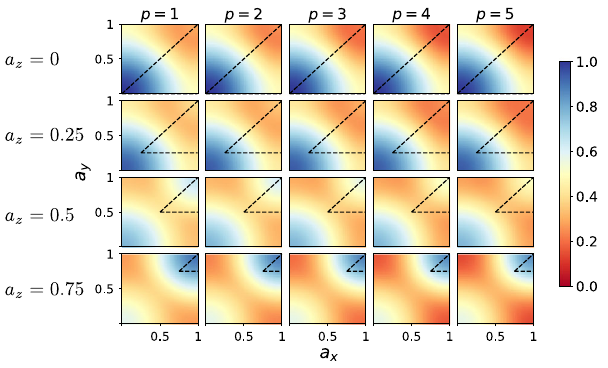
FIG. 22. j λ 2 j for the PBC case at n ¼ 10 . The columns represent a fixed configuration, and the rows represent a fixed value for the parameter a . z